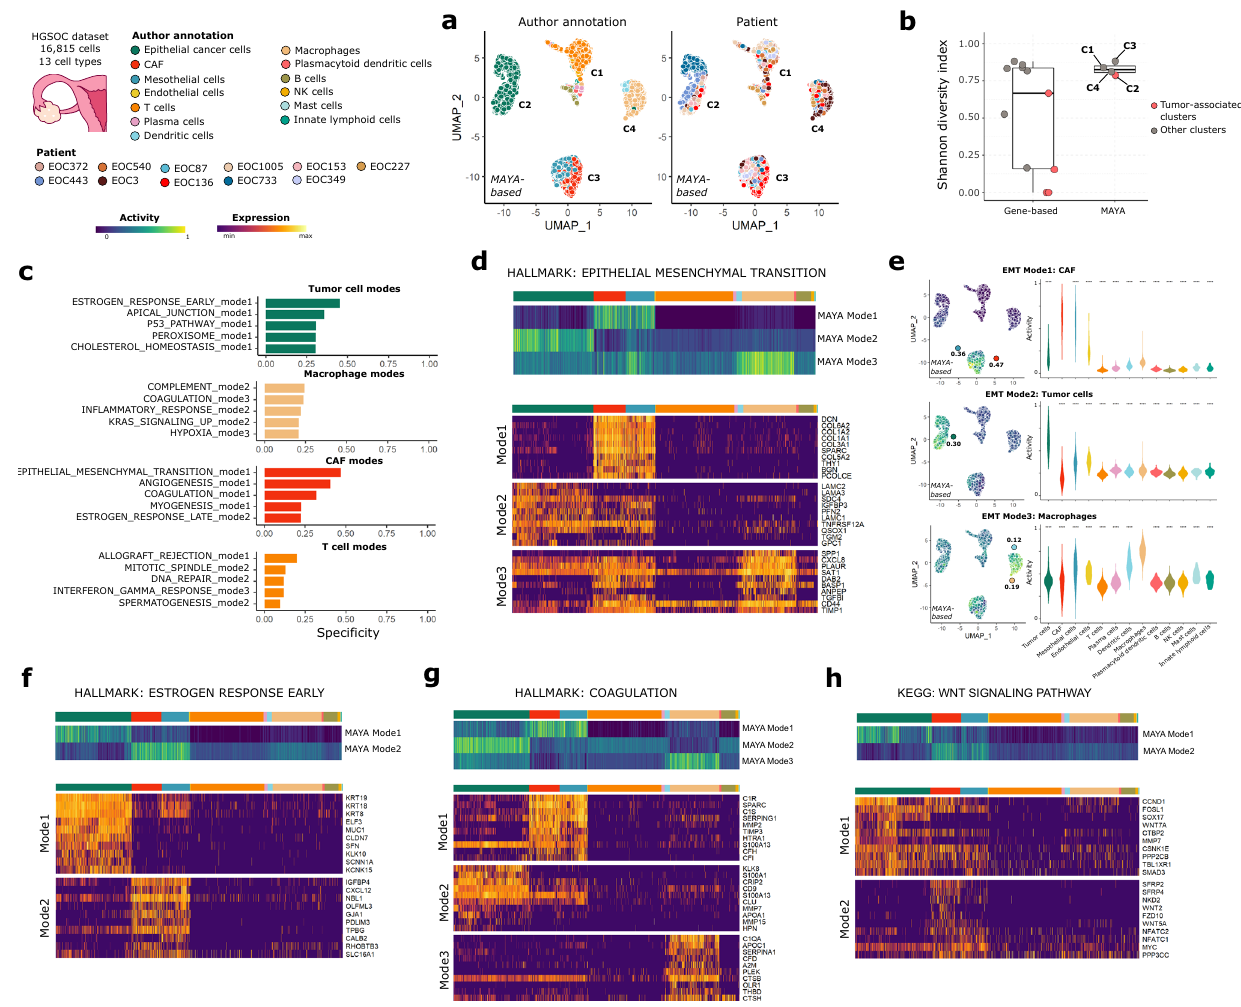
Fig. 5 | MAYA detects pathway activation in tumors across patients. a UMAP representationofactivitymatrixofHallmarkpathways,cellsarecoloredaccording to author annotation and patient. Clusters derived from activity matrix are dis- playednexttorelevantgroupsofcells. b Overlaidjitterandboxplotrepresentation of Shannon Diversity Index (SDI), for clusters derived from gene-based dimen- sionality reduction and MAYA activity matrix of the ovary dataset. Clusters corre- sponding to tumor cells are colored in pink; n =11 and 4 independent clusters respectively; Center line, median; box limits, upper and lower quartiles; whiskers, 1.5× interquartile range. c Barplot representation of speci fi city scores of the top5 speci fi c modes for the four most prevalent populations in the dataset. d Heatmap of activity scores of the three modes of the Hallmark Epithelial Mesenchymal Transition (EMT) pathway, initial author annotation is indicated